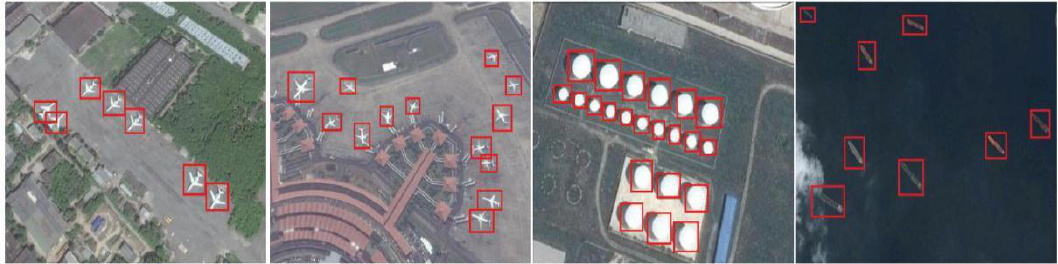
Figure 5. Sample images from the constructed remote sensing image dataset. The detection targets are annotated with ground truth boxes.